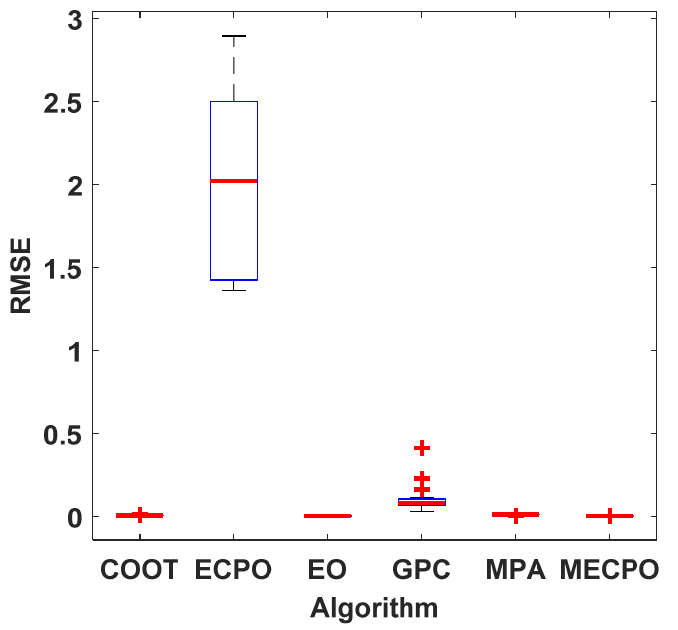
Figure 17. Best RMSE boxplot in 20 individual runs of the MECPO and other recent algorithms for the TDM. Table 14. Measured and simulated data of voltages, currents, and power and the absolute errors values using MECPO for TDM.